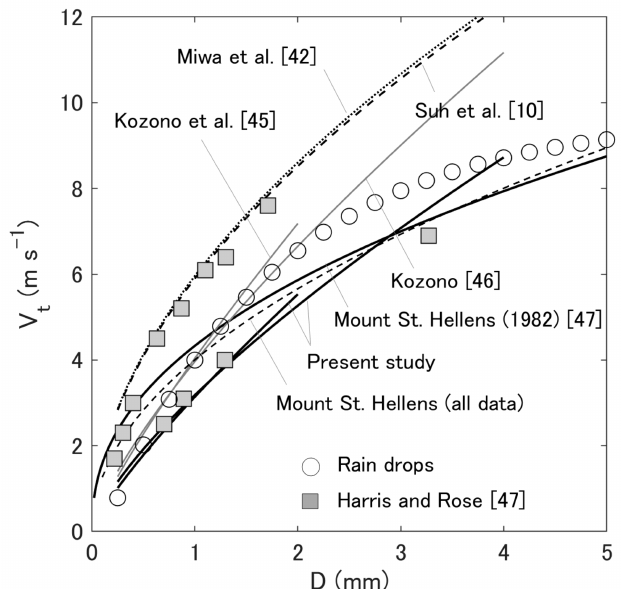
Figure 4. Relationships between ash particle fall velocity and diameter proposed in previous studies and the present